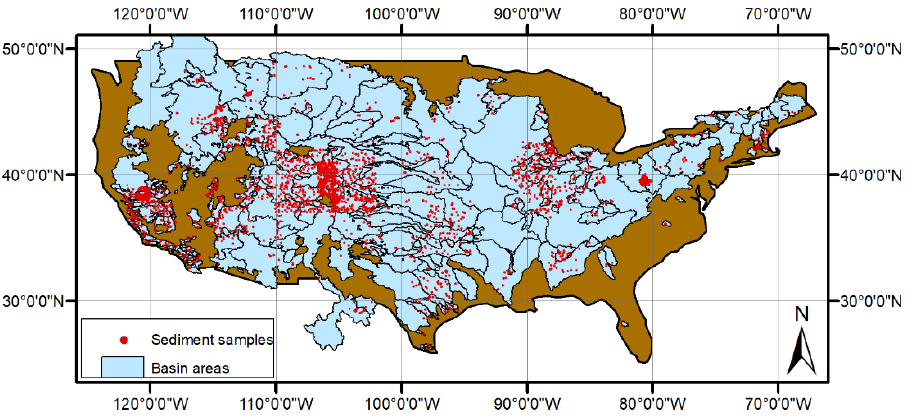
Figure 2. The basin areas for which factor data were collected and the positions of the sediment samples in the contiguous United States.